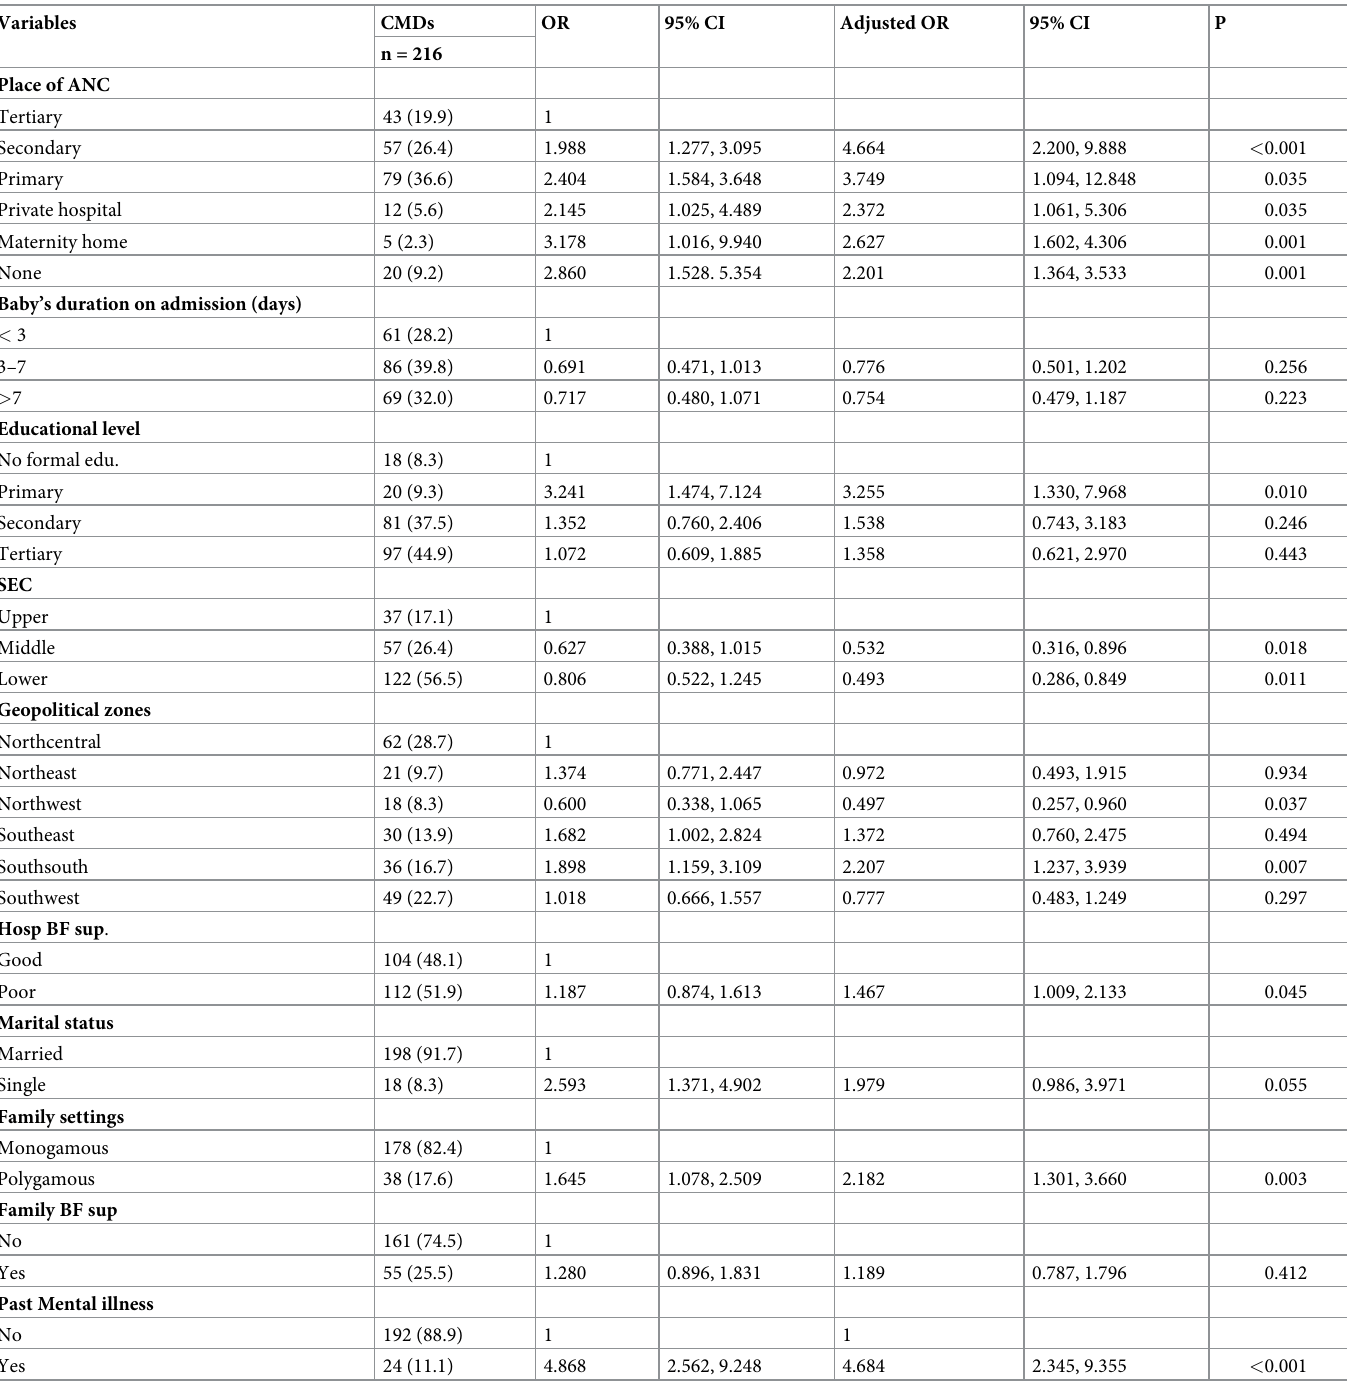
Table 3. Multivariable logistic regression of factors associated with